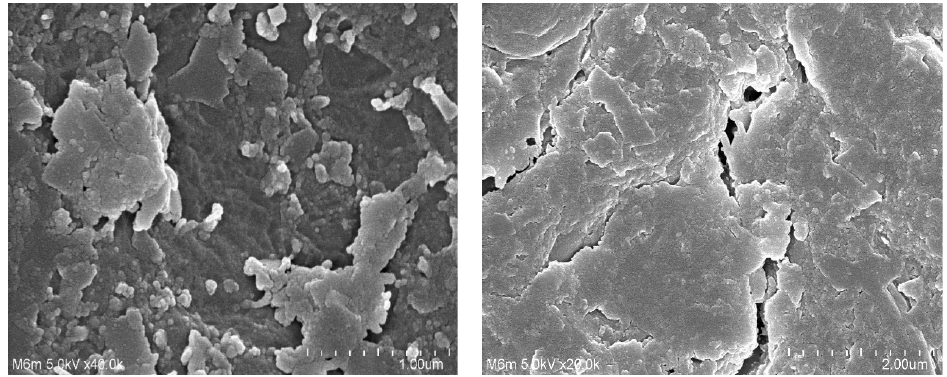
Figure 5. Scanning electron microscopy of β -CD- g -P(Aa/Ia) hydrogel .